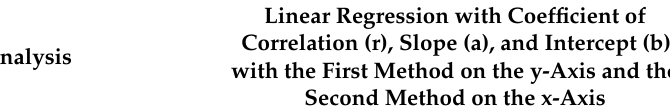
Linear Regression with Coefficient of Correlation (r), Slope (a), and Intercept (b) with the First Method on the y-Axis and the Second Method on the